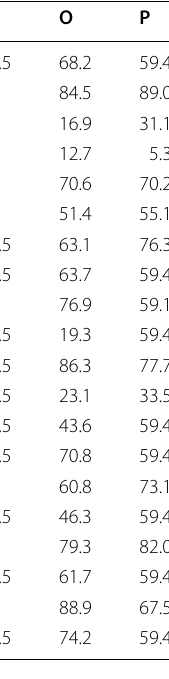
Table 2 Matrix of observed and predicted